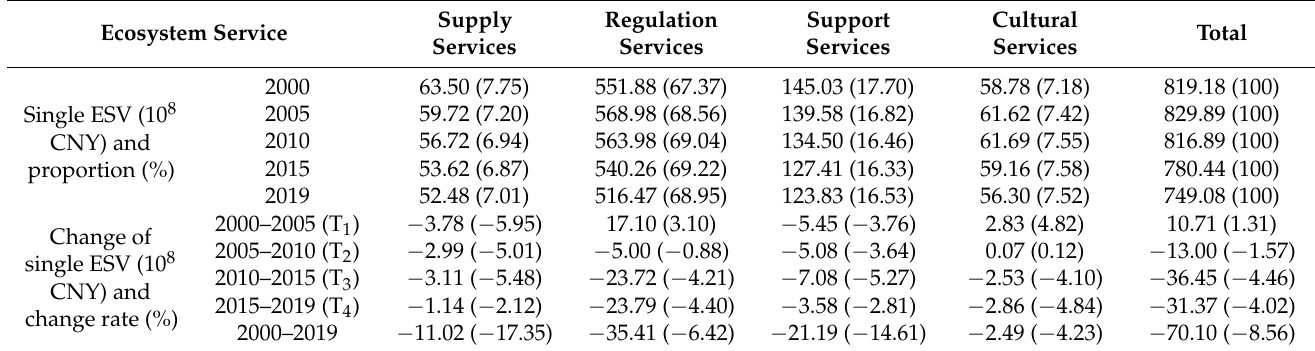
Table 3. Structure change of ESV from 2000 to